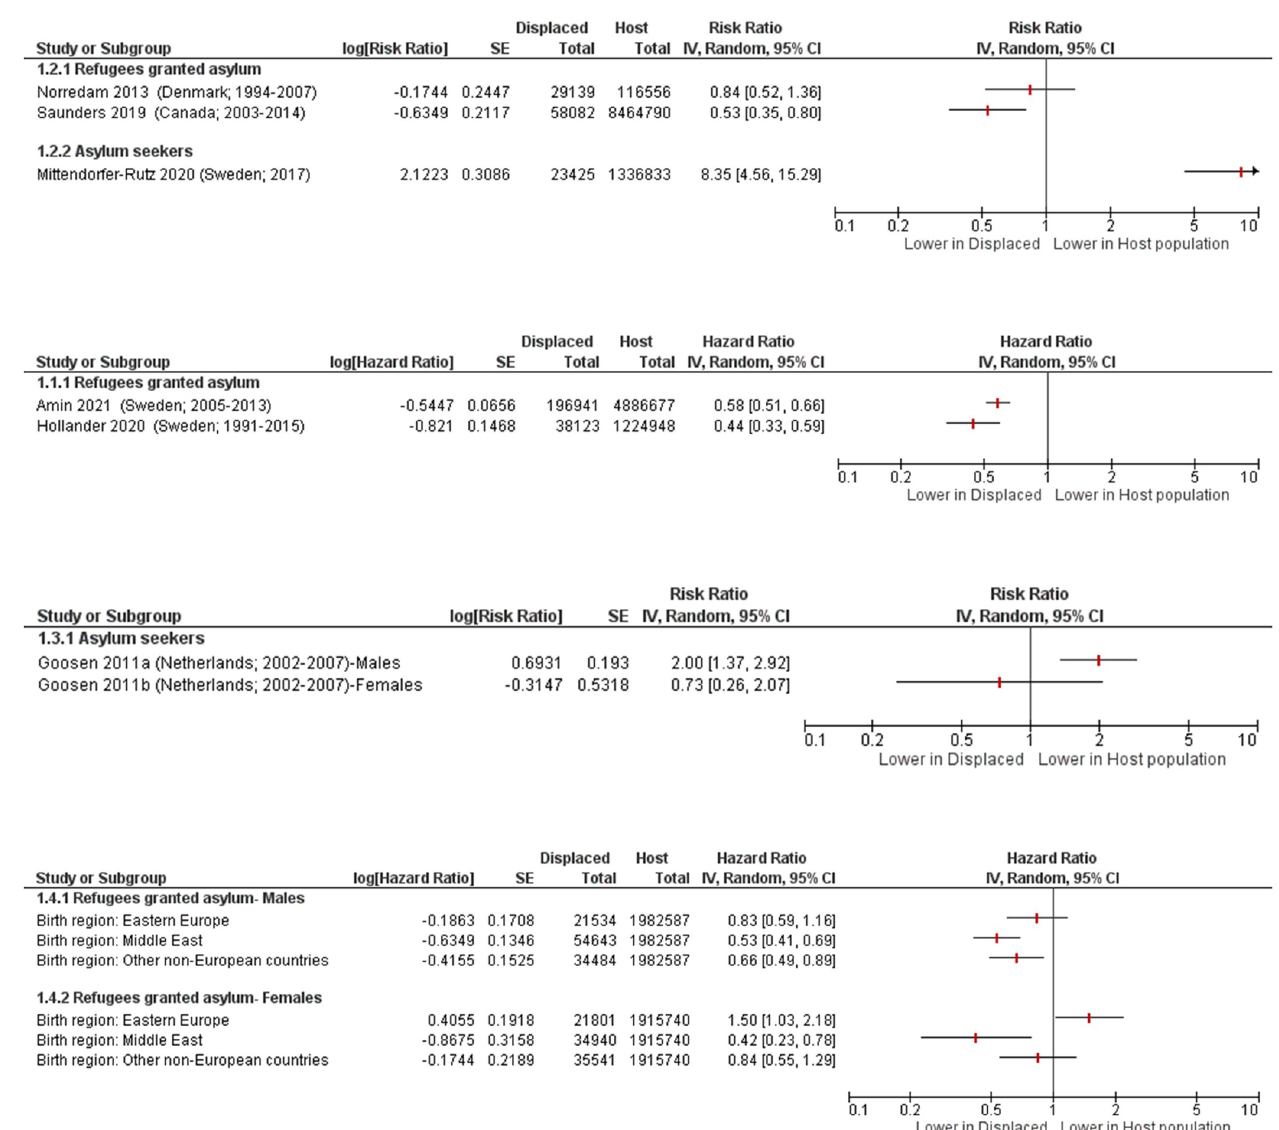
Fig 2. Suicide in displaced people compared to host country population. Norredam 2013 [62] adjusted for age and income; Amin 2021 [20] adjusted for socio-demographic, labour market marginalisation and morbidity factors (i.e. sex, age, educational level, family situation and type of residential area, days with full-time unemployment, net days with sickness absence, granted disability pension, history of suicide attempt; history of inpatient or specialised outpatient healthcare); Hollander 2020 [42] adjusted for attained age, gender, and disposable income; Goosen 2011 [37] standardised for age; Westman 2006 [89] adjusted for age, marital status, socioeconomic status, and hospitalization for psychiatric disorders or substance abuse; Saunders 2019 [73] and Mittendorfer-Rutz 2020 [57] were